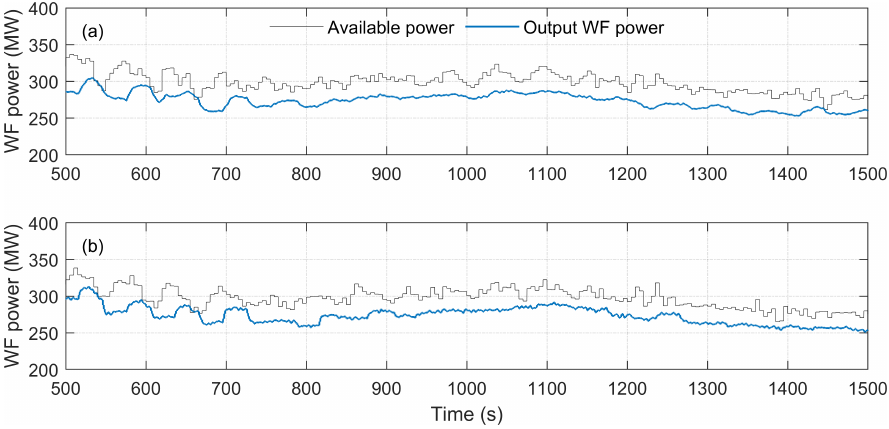
Figure 21. Total output power of offshore wind farms under deloaded operation: ( a ) Semi-based wind farm; ( b ) Spar-based wind